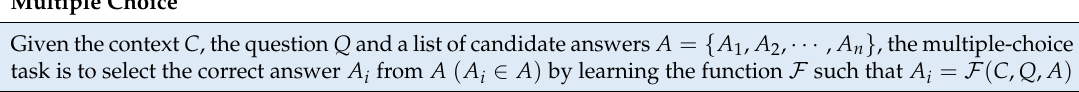
Table 4. Definition of multiple choice.